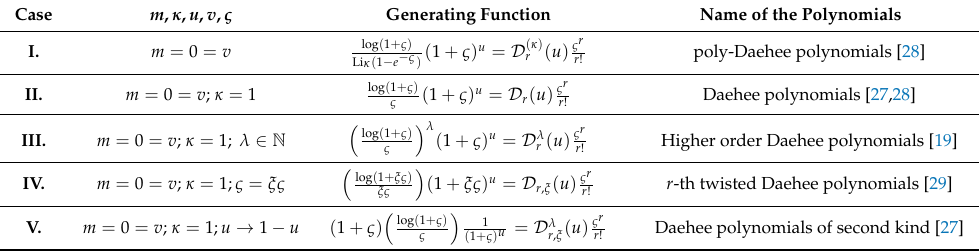
Table 1. Some known polynomials occurring as special cases of